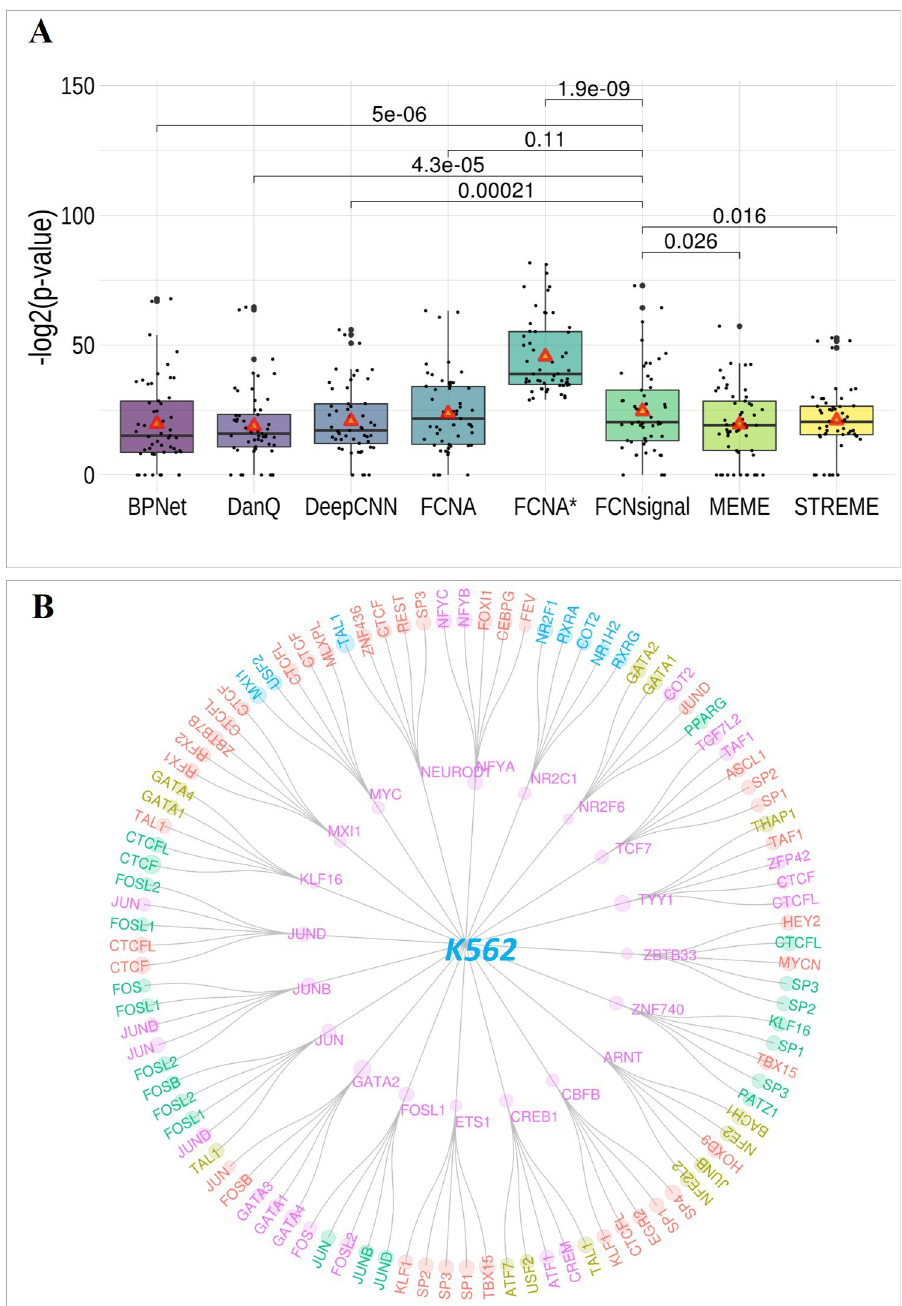
Fig 3. Motif prediction performance comparison of FCNsignal and the competing methods. (A) The–log2(p-value) values for BPNet, DanQ, DeepCNN, FCNA, FCNA � , FCNsignal, MEME and STREME, and the Wilson’s test p-values (paired) between FCNsignal and other seven methods. Note that the red triangles represent the average values and the value of 0 means not finding the target. (B) Detailed view of identified TF motifs for K562. The TF motifs of the inner loop are the target ones and the motifs of the outer loop are the found ones. The size of circles corresponds to the–log2 (p-value) value and different colors are used to designate different TF classes. The TF motifs marked by ‘pink’ belong to the same TF family sharing the consensus binding sequence while the ones marked by other colors are more likely the indirect TF motifs.